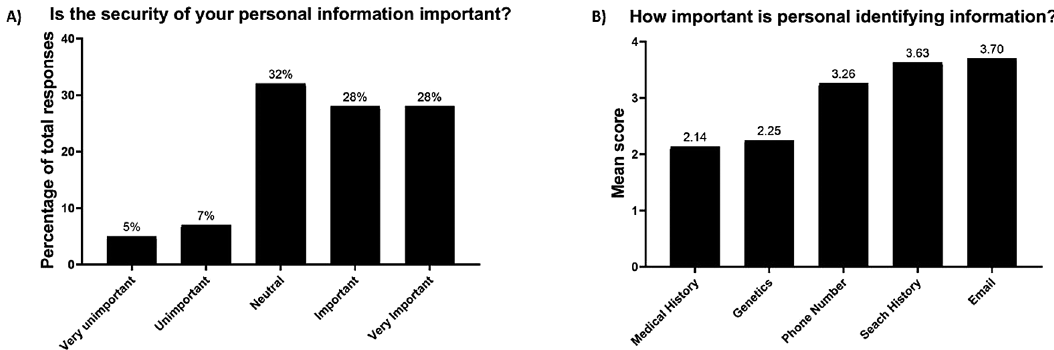
Figure 1. Attitudes toward the importance of genetic security (A) and the level of importance of (Scale 1-5) of personal identifying information (B).